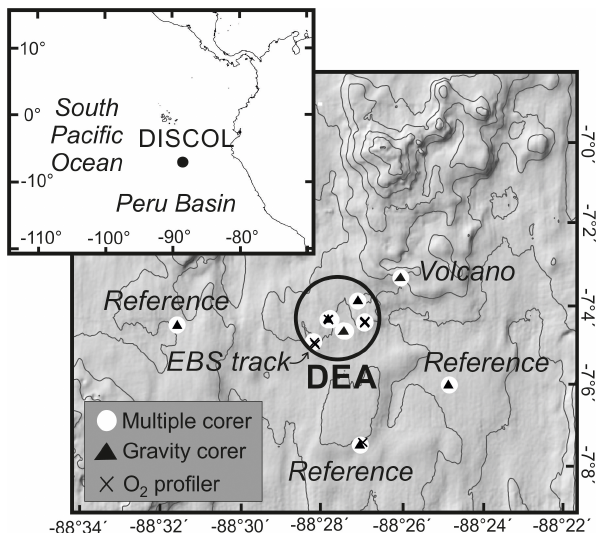
Figure 1. Bathymetric map of the DEA region in the Peru Basin including the sampling stations presented in this work. More details on the sampling locations are provided in Table 1.